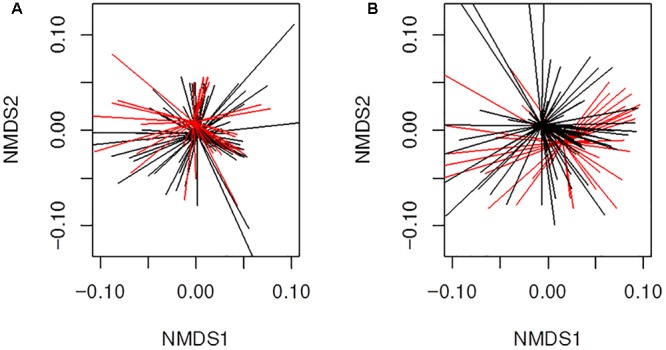
Beta-diversity analyses of all samples (n = 130) from infants with CF for ampicillin resistance using non-metric multidimensional scaling (nMDS). Illustrated are (A) results for abundance based distance matrix (permutational multivariate ANOVA P = 0.04) and (B) binary based distance matrix (permutational multivariate ANOVA P = 0.001). Ampicillin-non-susceptible samples were more similar to each other than compared with susceptible sample. Red; Sample is ampicillin-non-susceptible. Black; Sample is susceptible toward ampicillin. Ordispider plots are illustrated which combine items to their centroid.